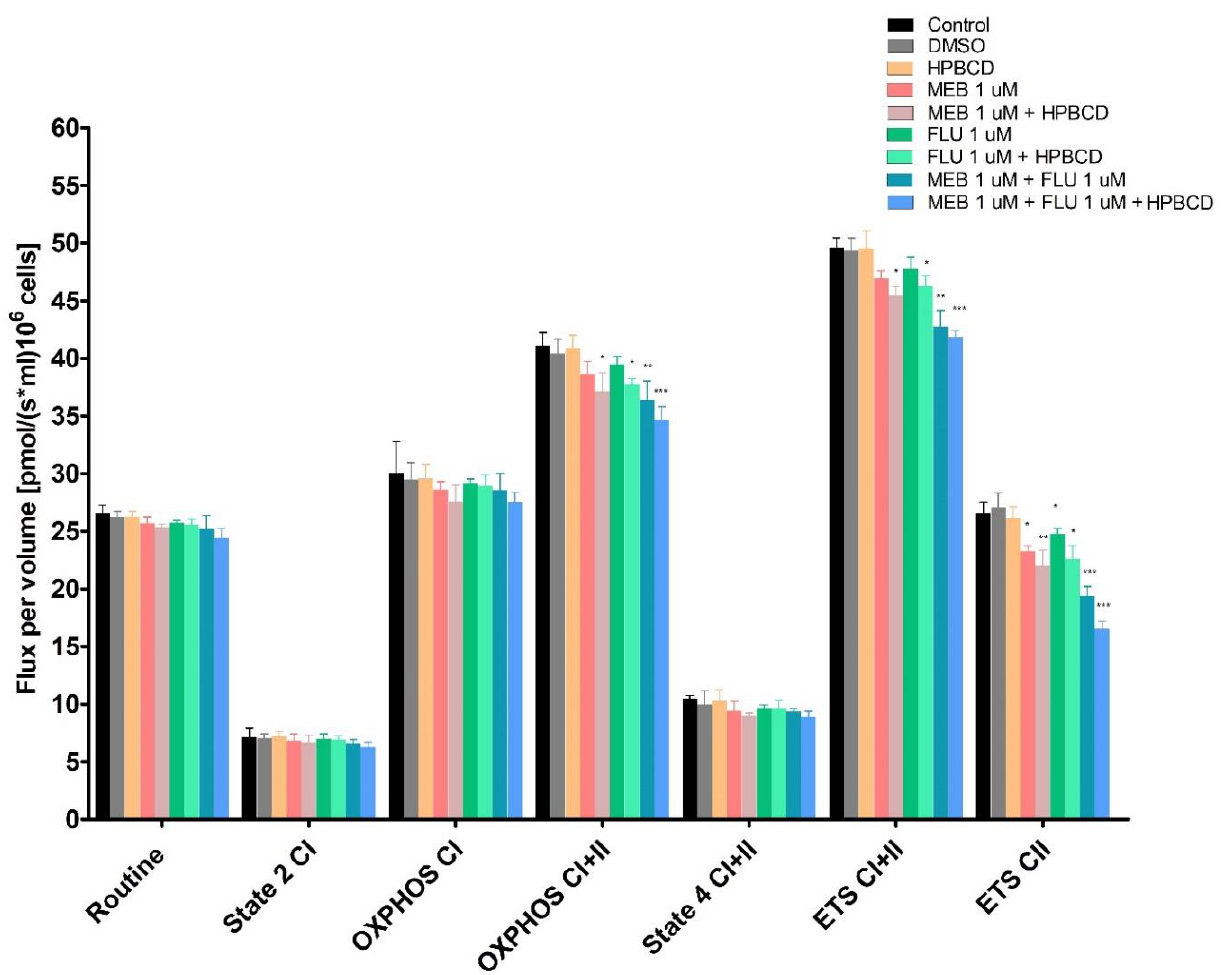
Figure 11. Mitochondrial respiration rates of permeabilized A549 non-small cell lung cancer cells following 72 h of stimulation with 1 µ M of HPBCD, MEB ± HPBCD, FLU ± HPBCD, and MEB + FLU ± HPBCD. The maximum concentration of DMSO used in this study was 0.25% and did not influence the mitochondrial function. The obtained data (pmol · s − 1 mL − 1 10 − 6 cells) is presented as mean ± SD of five individual experiments. The statistical analysis was performed using two-way ANOVA, followed by Bonferroni post-test (* p < 0.05, ** p < 0.01, and *** p < 0.001).